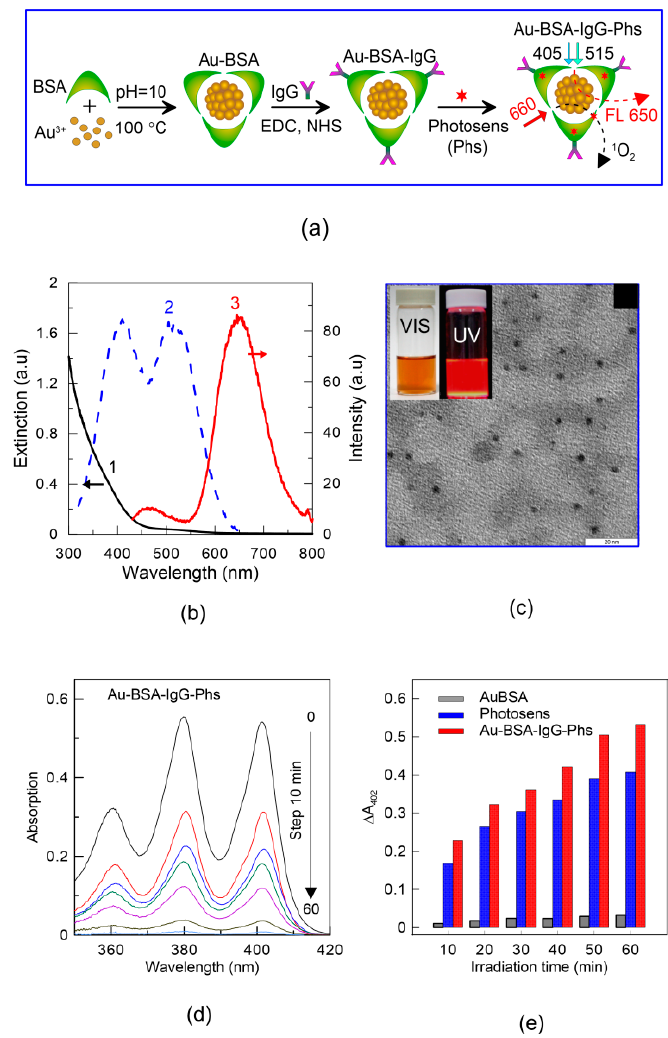
Figure 9. Scheme of the preparation of the Au-BSA-IgG-PS complexes and their fluorescent and PDT properties under 405, 515 nm and 660 nm-excitation, respectively ( a ); extinction (1), excitation (2), and emission (3) spectra of Au-BSA NCs ( b ); TEM images of Au-BSA NCs, the insets show the photos of the solutions under white light ( left ) and UV light ( right ) irradiation, The scale bar is 20 nm ( c ); absorption spectra of a mixture of ABDA and Au-BSA-IgG-Phs under illumination by a 633-nm laser for different exposures from 0 to 60 min ( d ); the absolute changes in ABDA absorbance at 402 nm and as a function of irradiation time; the gray, blue, and red columns correspond to incubation of bacteria in Au-BSA NCs, Photosens solution, and Au-BSA-IgG-PhS NCs, respectively ( e ). Reproduced from [74] with permission from The Royal Society of Chemistry.